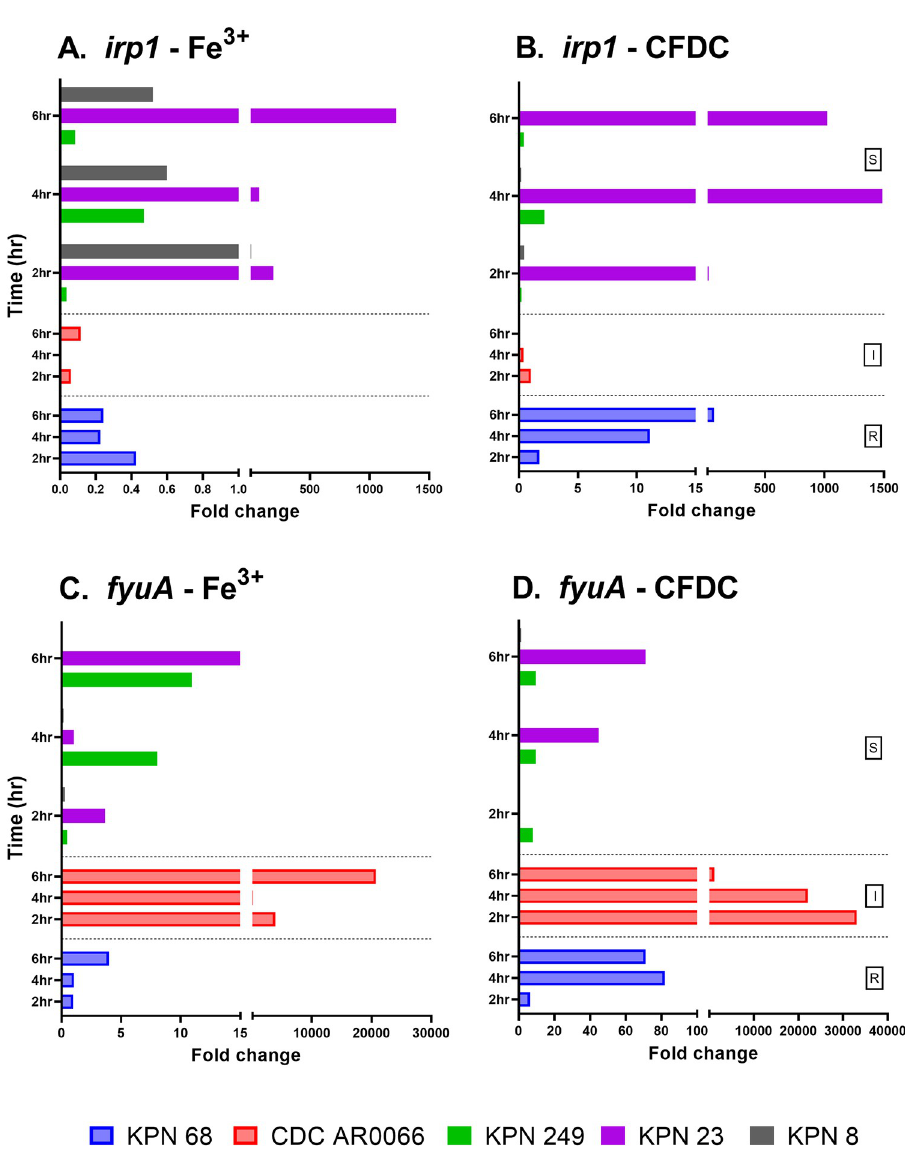
Fig 4. Gene expression of yersiniabactin ( irp1 ) and its receptor ( fyuA ) in strains overtime in different media. Fold changes of expression were calculated for strains grown in different media by comparing the expression of each gene for bacteria treated with CFDC or grown in iron enriched media to the expression of the same gene at the same time point when the bacteria were grown in iron depleted media.